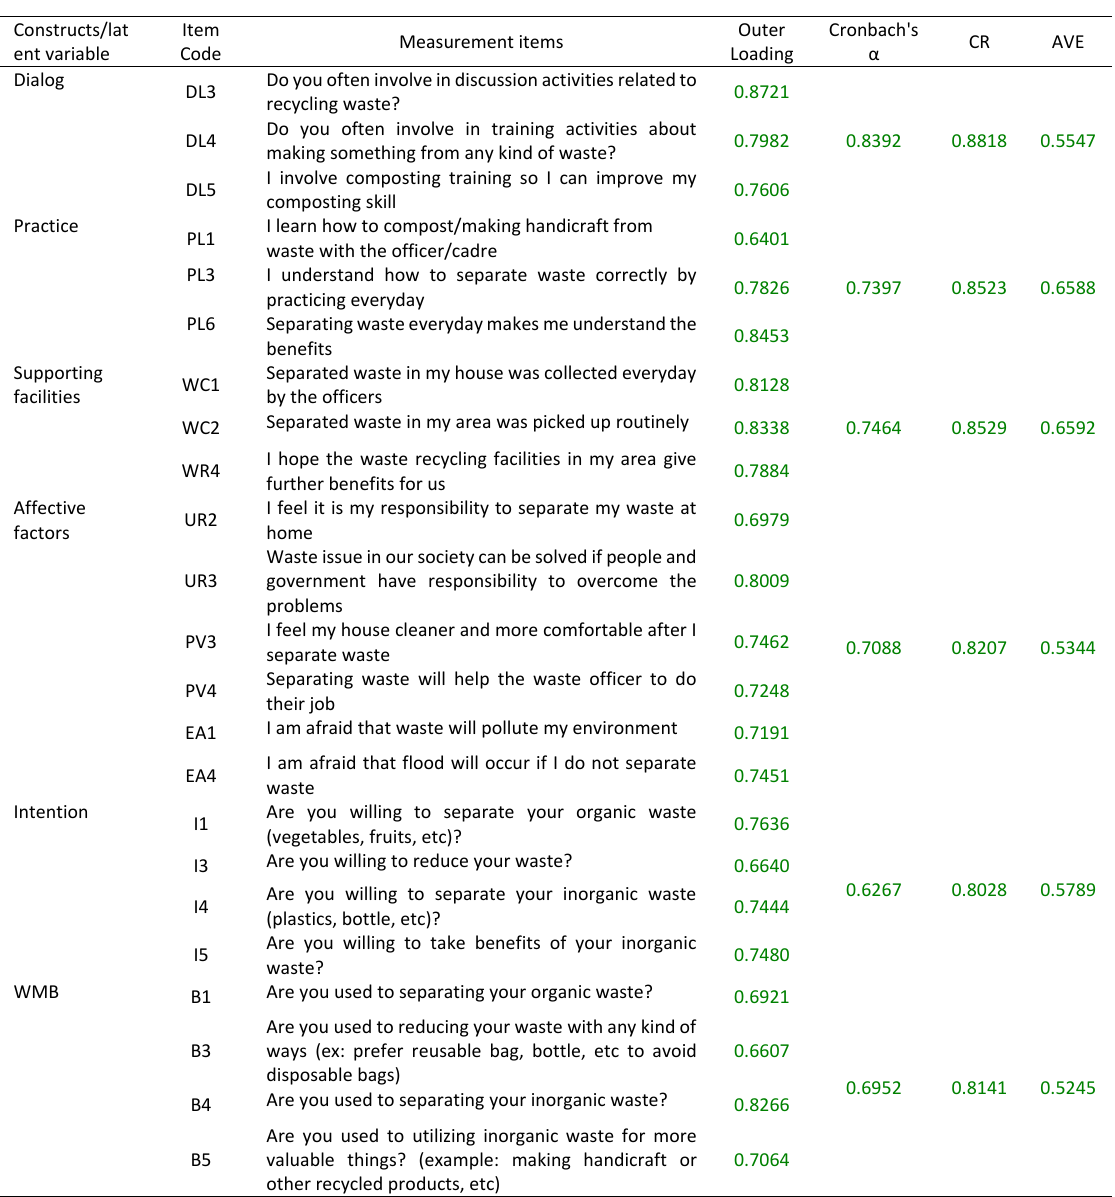
Table 6: The final outer model